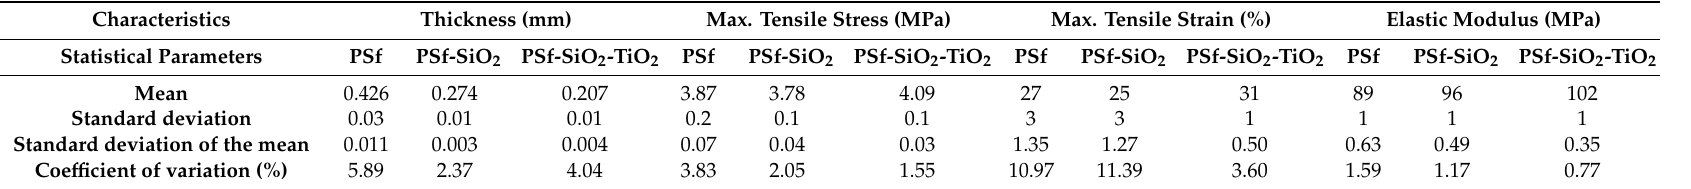
Table 5. Statistical parameters calculated for polysulfone and polysulfone composite